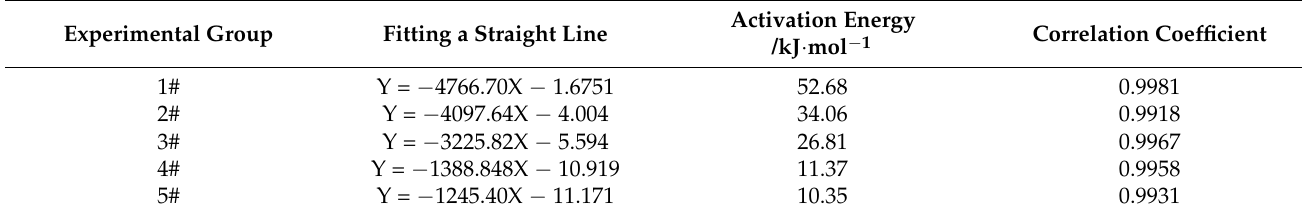
Table 2. Kinetics